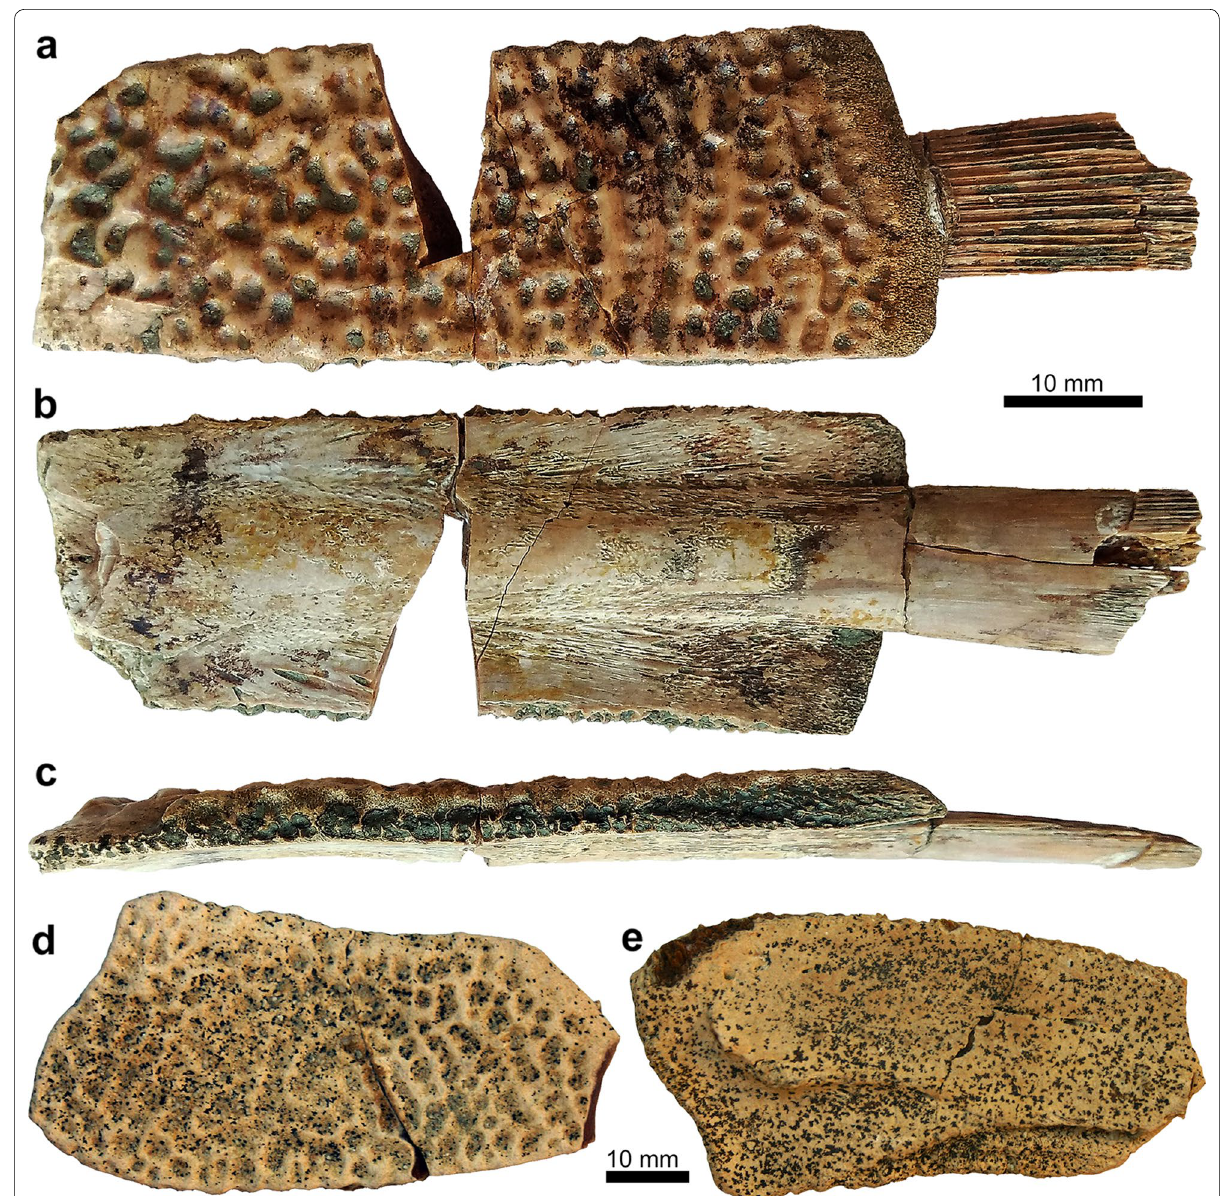
Fig. 2 Trionyx pliocenicus from Cessaniti; carapace material. a – c Costal (MSNC 4591) of a juvenile in dorsal ( a ), ventral ( b ), and lateral ( c ) views; d – e costal fragment (MSNC 4590) in dorsal ( d ) and ventral ( e )